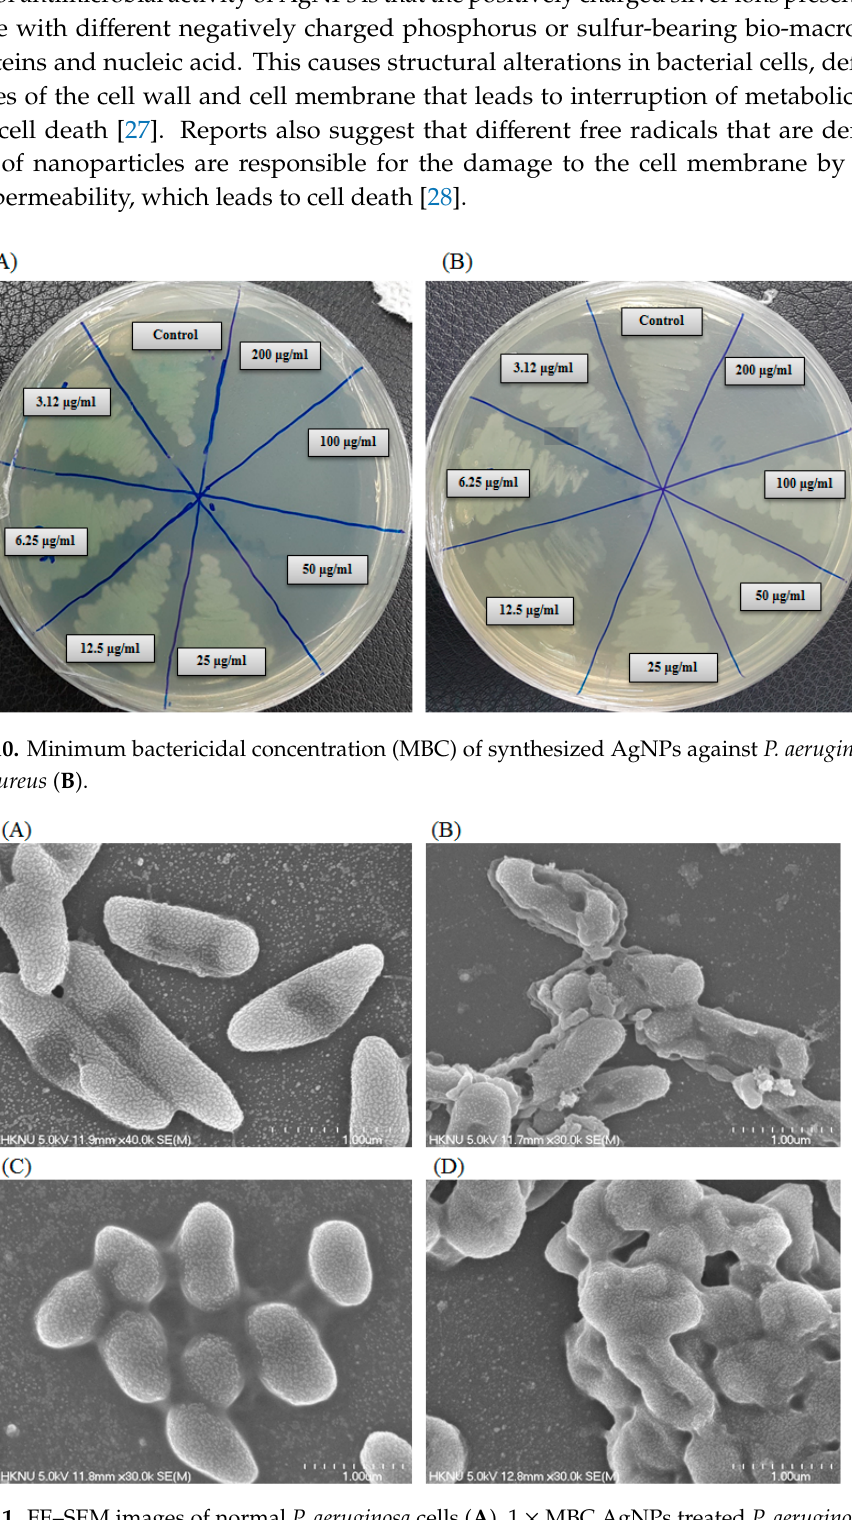
Figure 11. FE–SEM images of normal P. aeruginosa cells ( A ), 1 × MBC AgNPs treated P. aeruginosa cells ( B ), normal S. aureus cells ( C ), 1 × MBC AgNPs treated S. aureus cells ( D ).